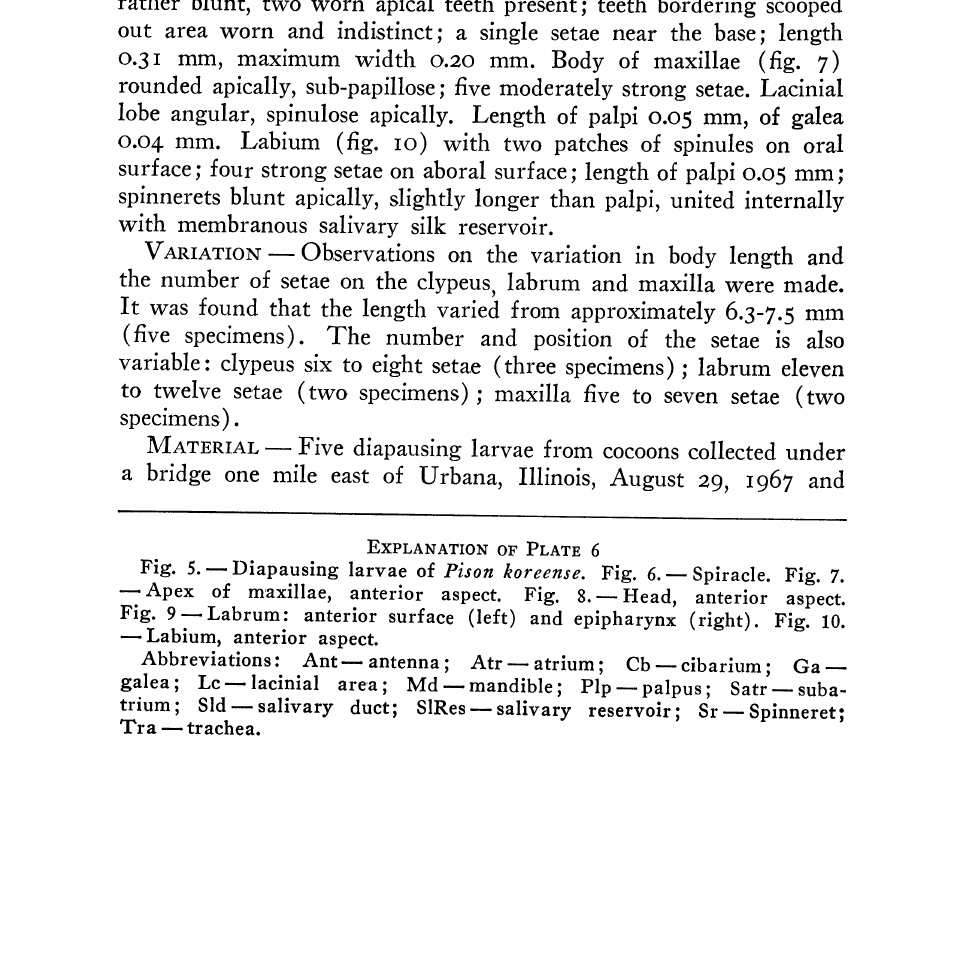
Fig. 9---Labrum: anterior surface (left) and epipharynx (right). Fig. 10. ---Labium, anterior aspect. Abbreviations" Ant--